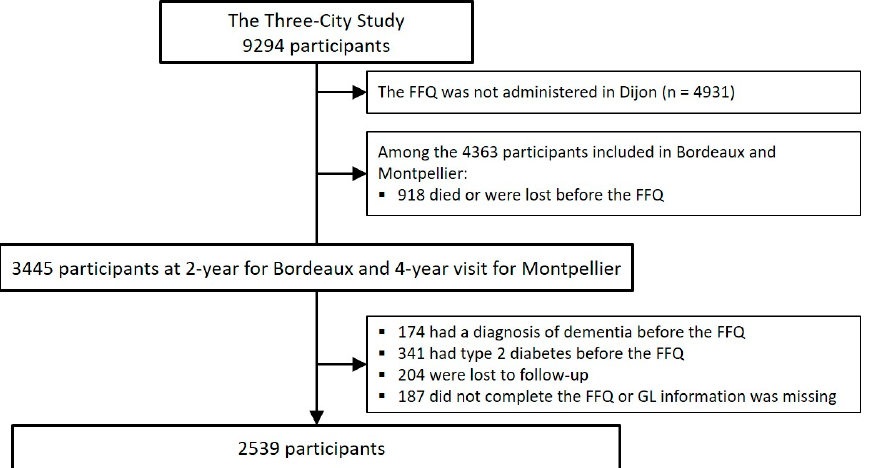
Figure 2. Three-City study flow chart.